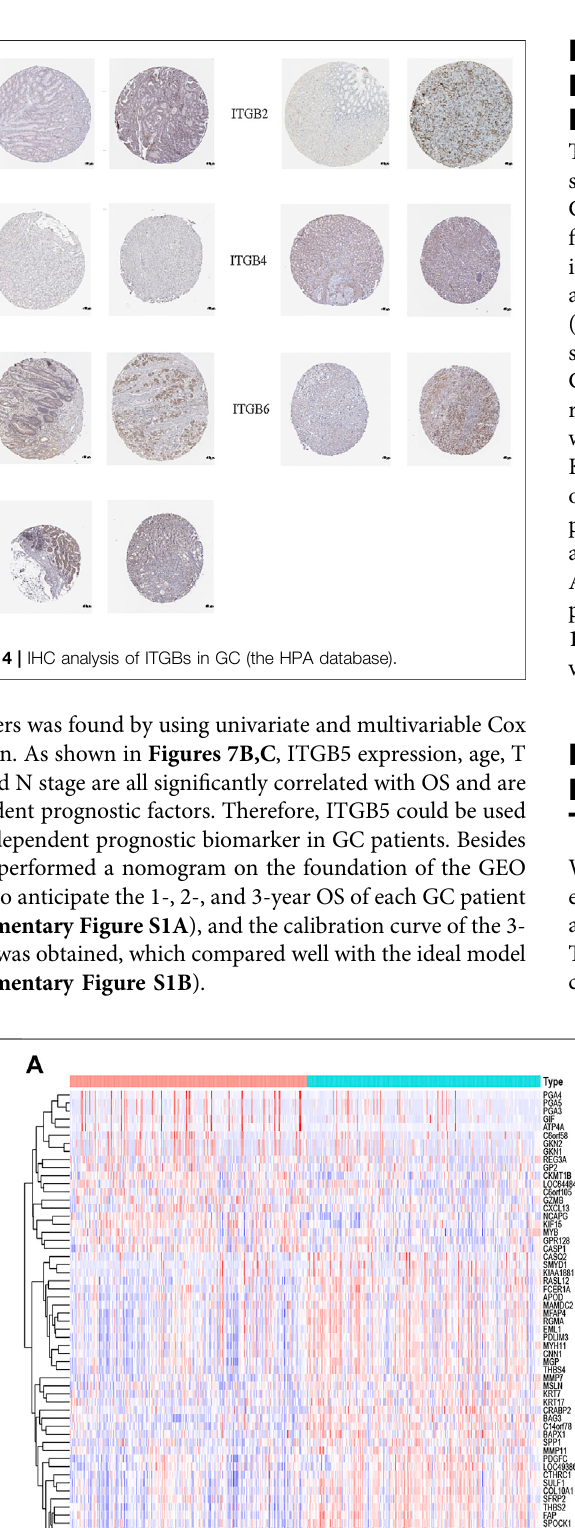
Frontiers in Cell and Developmental Biology |